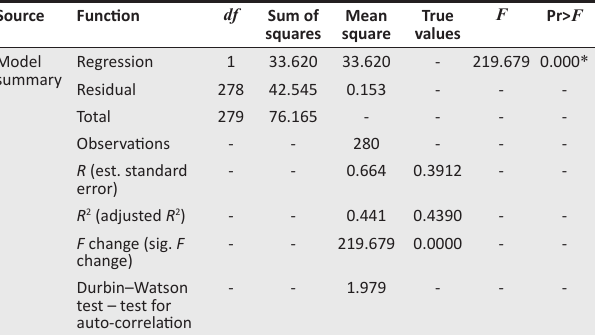
TABLE 7: Simple linear regression model fit and summary for absorptive capacity on small and medium enterprises’ innovation capabilities.